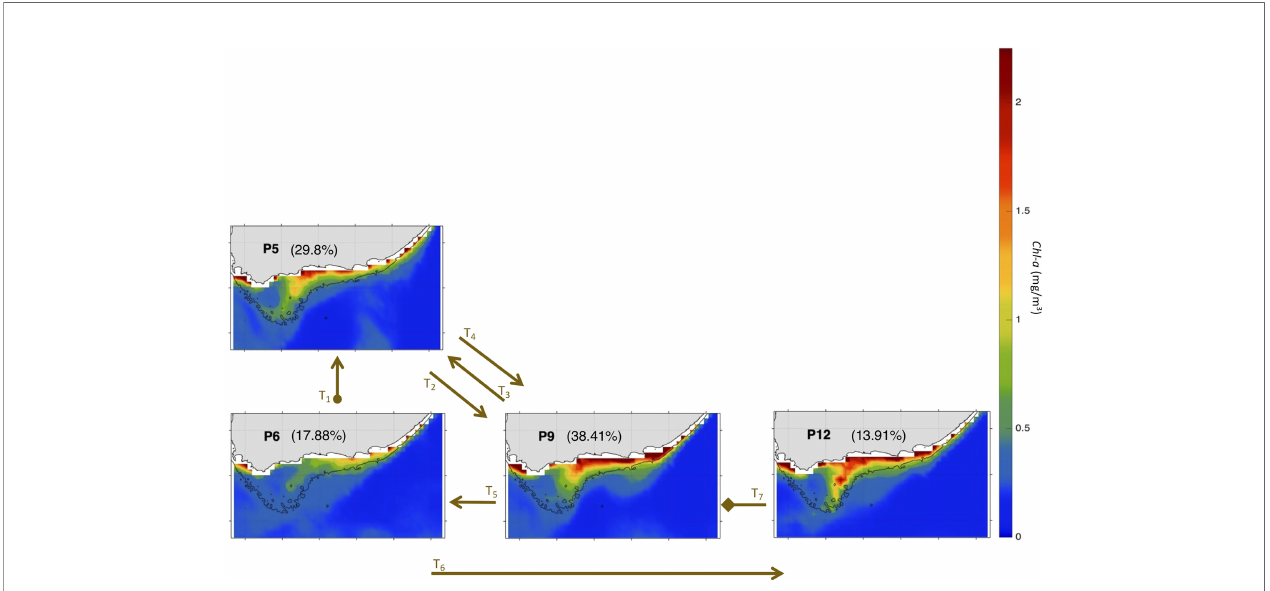
FIGURE 9 | Same as Figure 4 but for Nov-Mar 2000-01. The frequency of occurrence of each pattern is calculated here relative to the days recorded during Nov-Mar 2000-01. The brown arrows represent the SOM patterns trajectories (T i=1:7 ) evolving during Nov-Mar 2000-01 as inferred from the BMU timeseries ( Supplementary Figure 4A ). The starting ( fi nal) trajectory is designated with a circle (diamond) at the arrow beginning